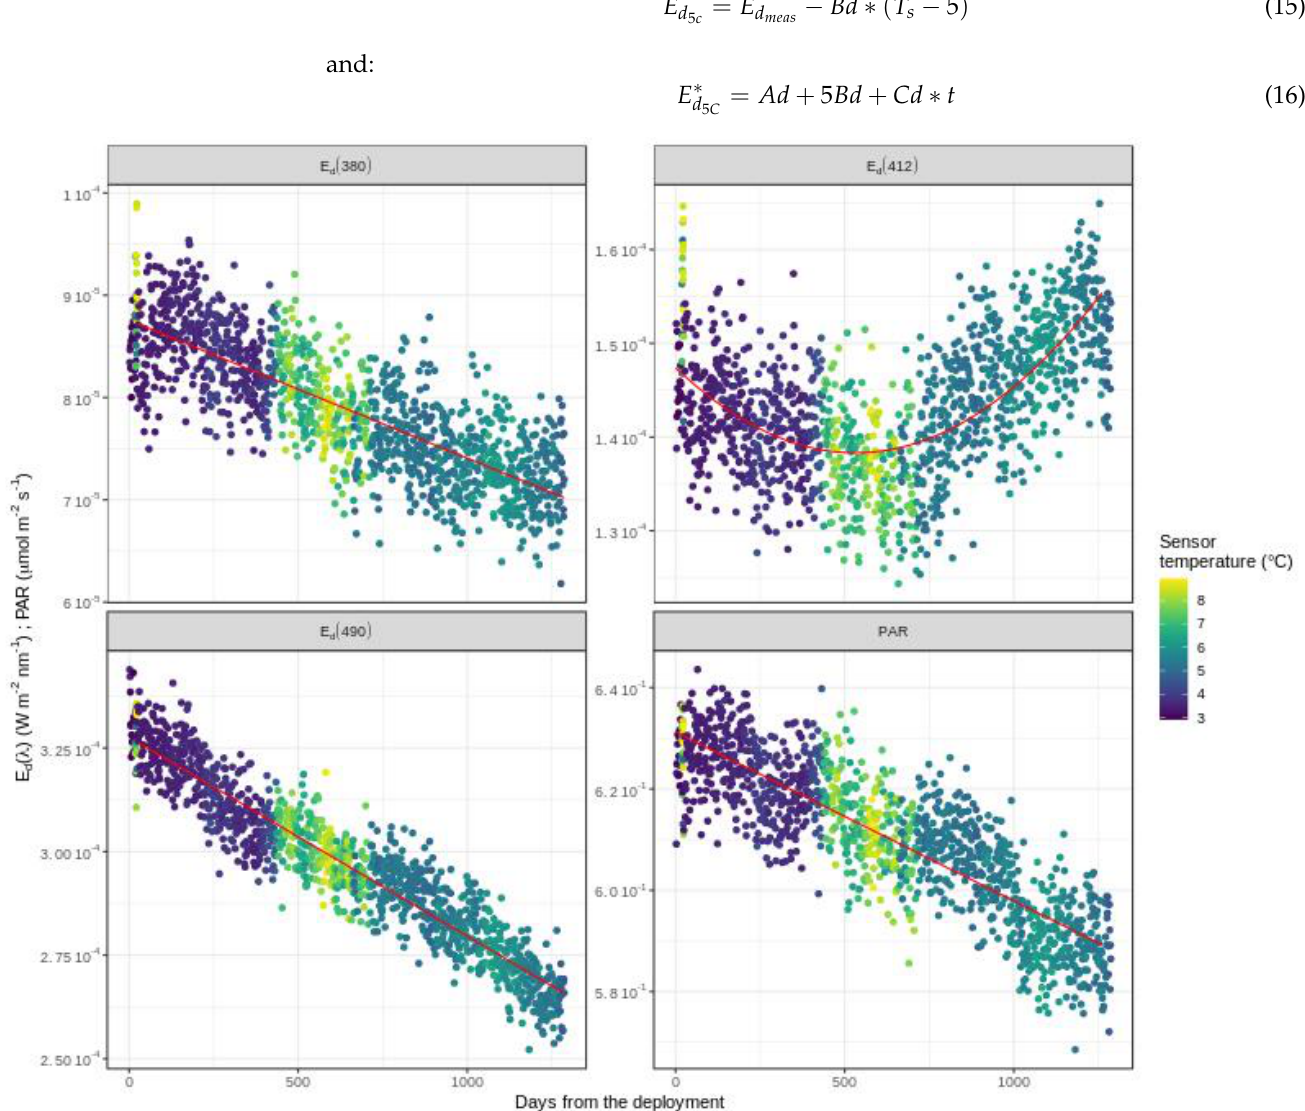
Figure 5. Radiometry drift measurements for E d ( λ ) and PAR as a function of time after estimation at a reference temperature of 5 °C. Solid line is the fit to all points. For this float, the fit is linear for all channels but E d (412). Example is shown for the float WMO6901584.